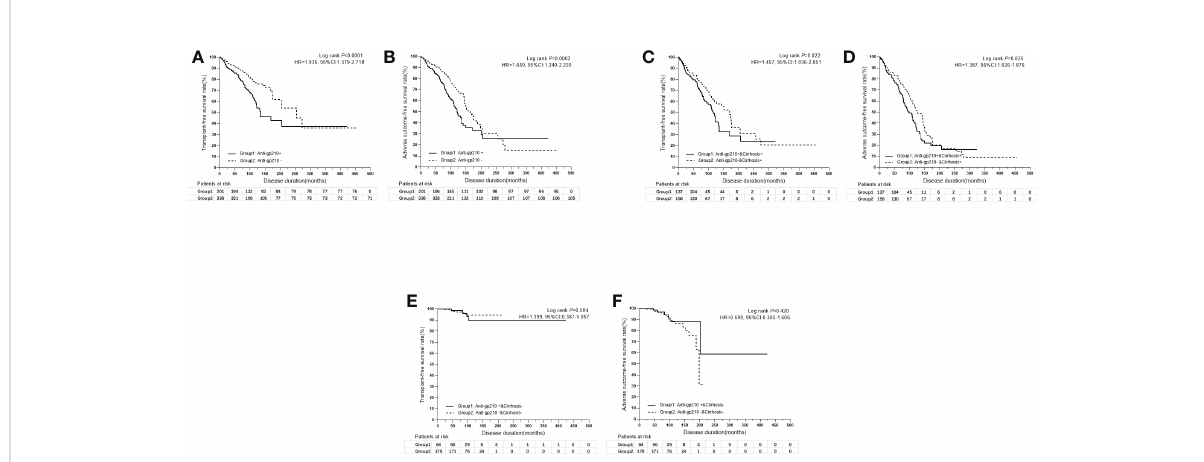
FIGURE 4 (A) Kaplan-Meier survival curves for the comparison of transplant-free survival rates between anti-gp210 positive PBC patients and anti-gp210 negative PBC patients. (B) Kaplan-Meier survival curves for the comparison of adverse outcome-free survival rates between anti-gp210 positive PBC patients and anti-gp210 negative PBC patients. (C) Kaplan-Meier survival curves for the comparison of transplant-free survival rates between anti-gp210 positive PBC patients with cirrhosis and anti-gp210 negative PBC patients with cirrhosis at baseline. (D) Kaplan-Meier survival curves for the comparison of adverse outcome-free survival rates between anti-gp210 positive PBC patients with cirrhosis and anti- gp210 negative PBC patients with cirrhosis at baseline. (E) Kaplan-Meier survival curves for the comparison of transplant-free survival rates between anti-gp210 positive PBC patients without cirrhosis and anti-gp210 negative PBC patients without cirrhosis at baseline. (F) Kaplan-Meier survival curves for the comparison of adverse outcome-free survival rates between anti-gp210 positive PBC patients without cirrhosis and anti- gp210 negative PBC patients without cirrhosis at